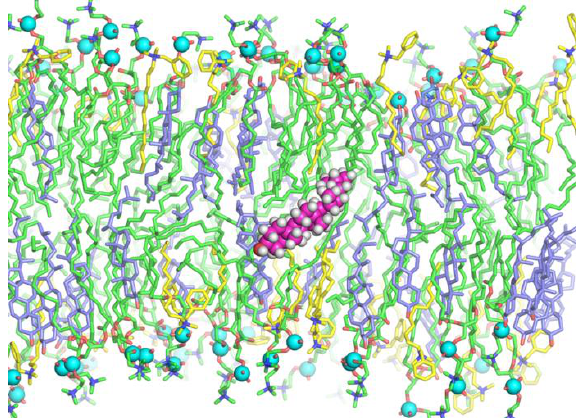
Figure 10. Plunging of cholesterol molecules into the bilayer for the highBacCholDOPC system. The plunging was observed twice during the 500-ns trajectory. Cholesterol molecules laid at the monolayer interface for 4 ns and 16 ns. C, H, and O atoms of the plunged cholesterol molecules are shown as magenta, white, and red spheres, respectively. Lipids are shown in stick representation, with phosphorus atoms indicated by cyan spheres. DOPC tails are shown as green sticks, cholesterol as blue sticks, O atoms as red sticks, and N atoms as blue sticks. BAC molecules are shown as yellow sticks.